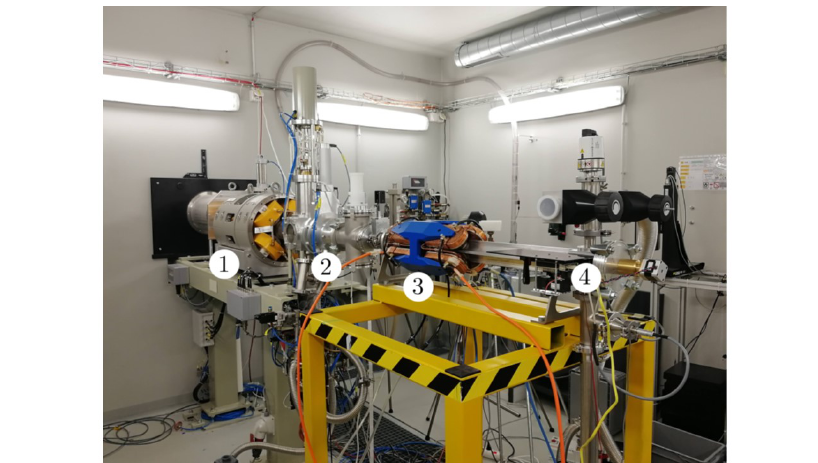
Figure 4. The setup used for the beam tests at the BTL of the Bern medical cyclotron. One of the two BTL quadrupole doublets (1), the π 2 detector (2), the MBL with its beam pipe containing the π 3 detector (3), and the motor with the pulley and vacuum valve system (4) are